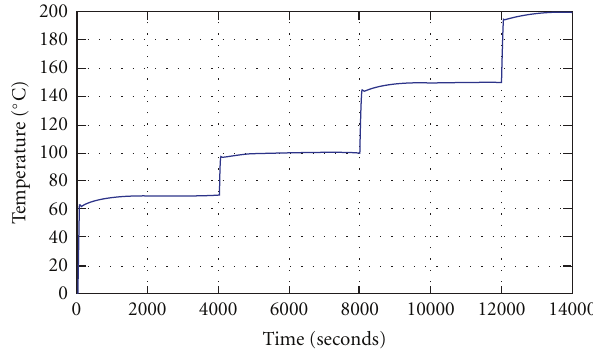
Figure 15: FLC control simulated output at di ff erent temperature set points.